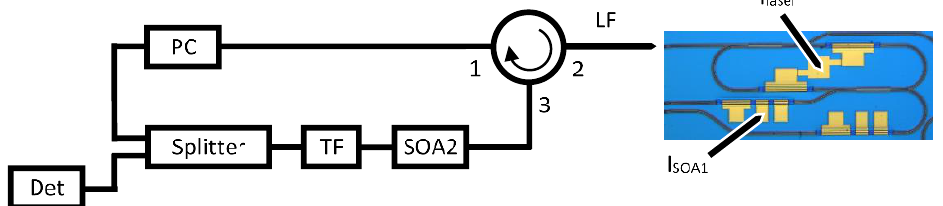
Figure 1. Image of the semiconductor ring laser with filtered feedback, in which the different laser and feedback components are indicated.